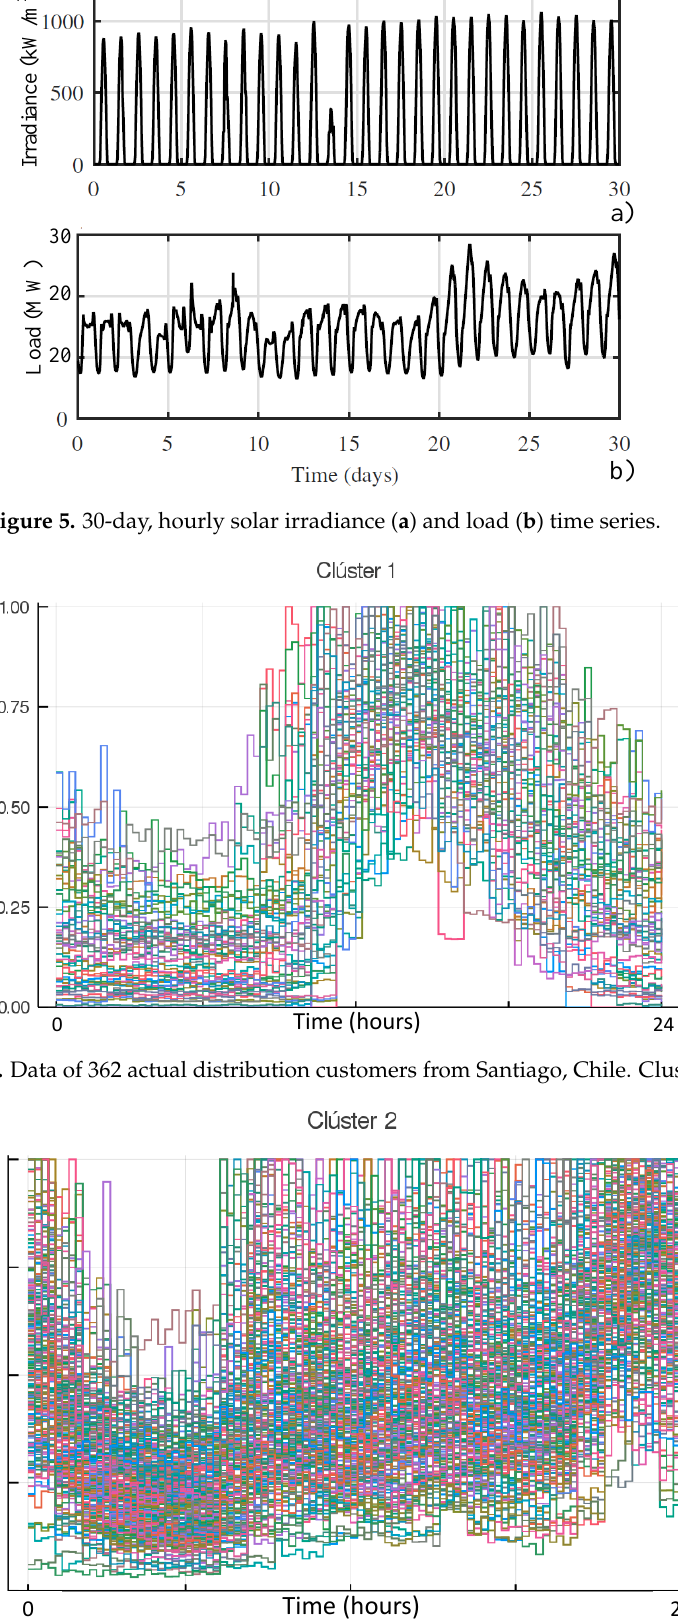
Figure 7. Data of 362 actual distribution customers from Santiago, Chile. Cluster